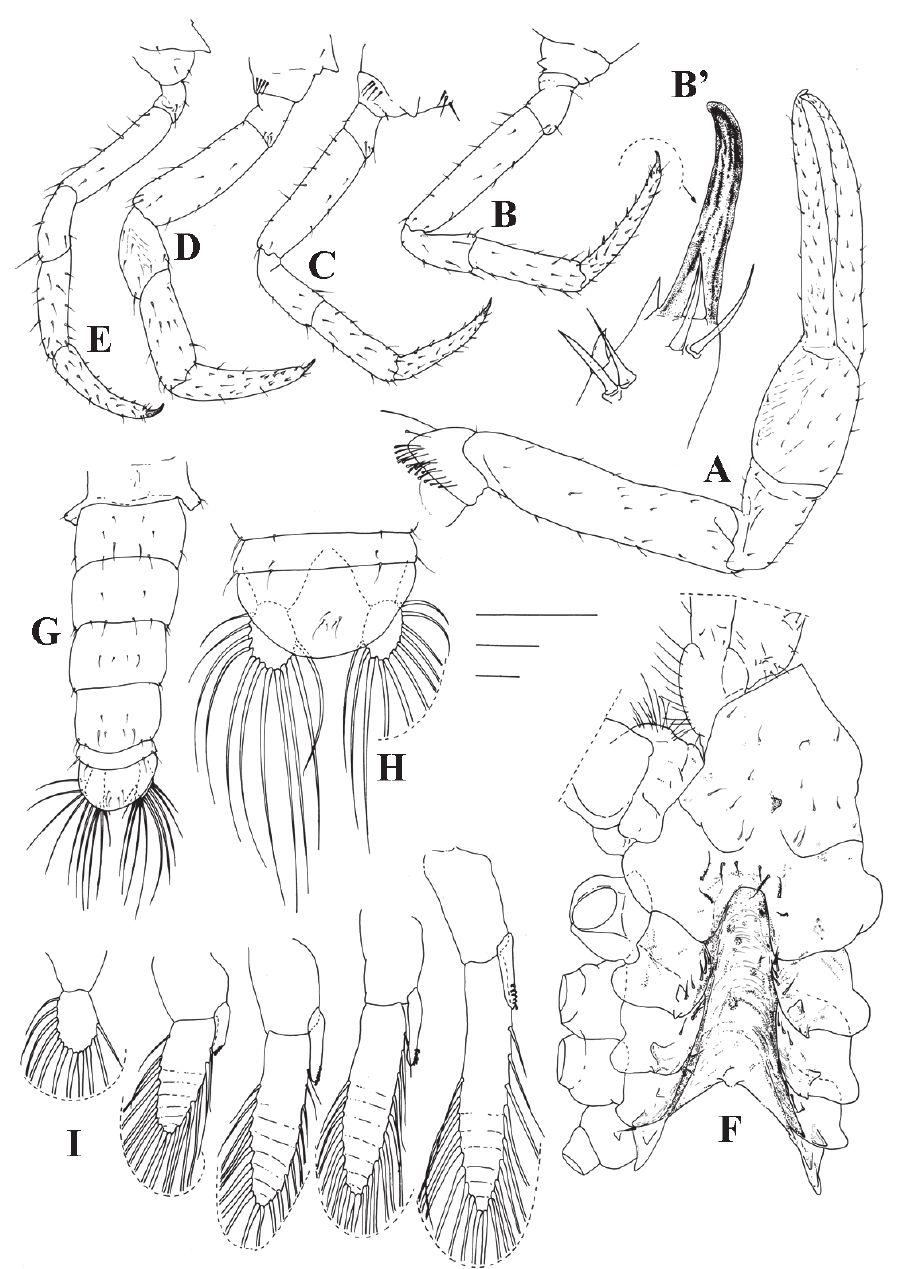
Fig . 6. – Ilia nucleus . Megalopa: a, first pereiopod; B, second pereiopod; B’, detail of dactylus of second pereiopod; C, third pereiopod; d, fourth pereiopod; e, fifth pereiopod; F, sternum; g, dorsal view of abdomen and telson; H, telson and uropods; i, pleopods. scale bars: 0.5 mm (a-e, g); 0.1 mm (B’, F, aesthetascs, 1 seta+ 7 aesthetascs, 4 aesthetascs, and 1 subterminal aesthetasc + 1 terminal seta. antenna (Fig. 5C): peduncle unsegmented with two simple setae and with the shortened exopod process; flagellum 4-segmented, segments first to fourth progressing proximally to distally, each with 0, 0, 0, 3 terminal (one shorter and two longer) sim- ple setae.